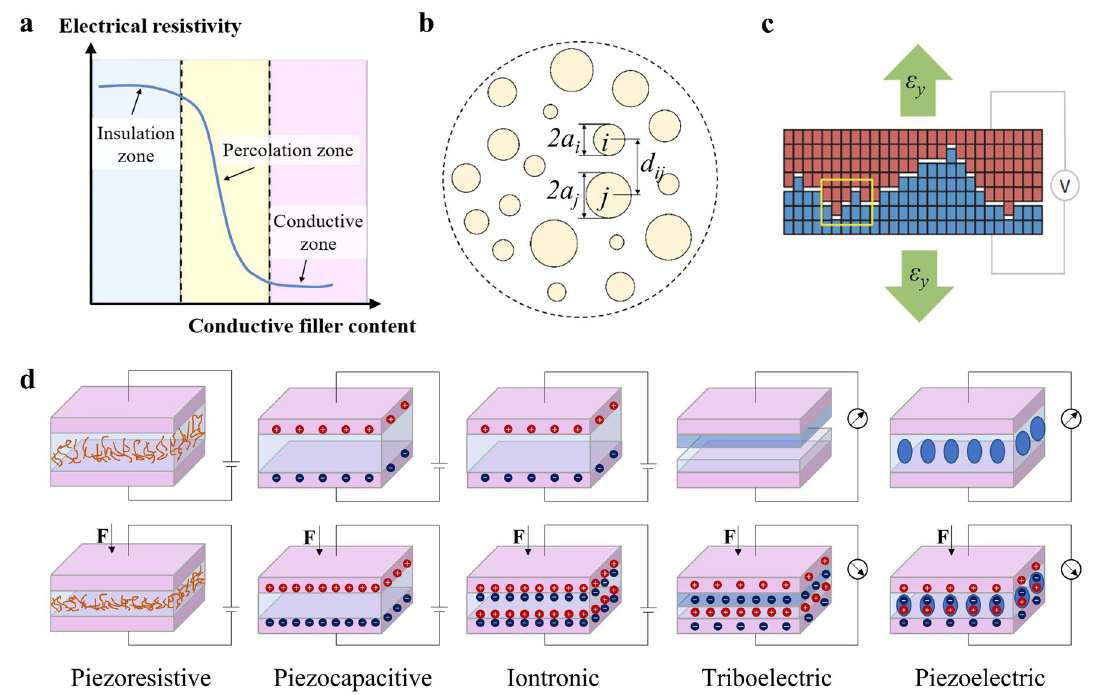
Fig. 2 Mechanical sensing mechanisms. a Percolation theory for conductive filler-doped polymer composites. b Contact resistance change anal- ysis for a simplified case of a set of circular contact spots. c Crack-induced resistance change analysis for a transverse crack with nanoscale